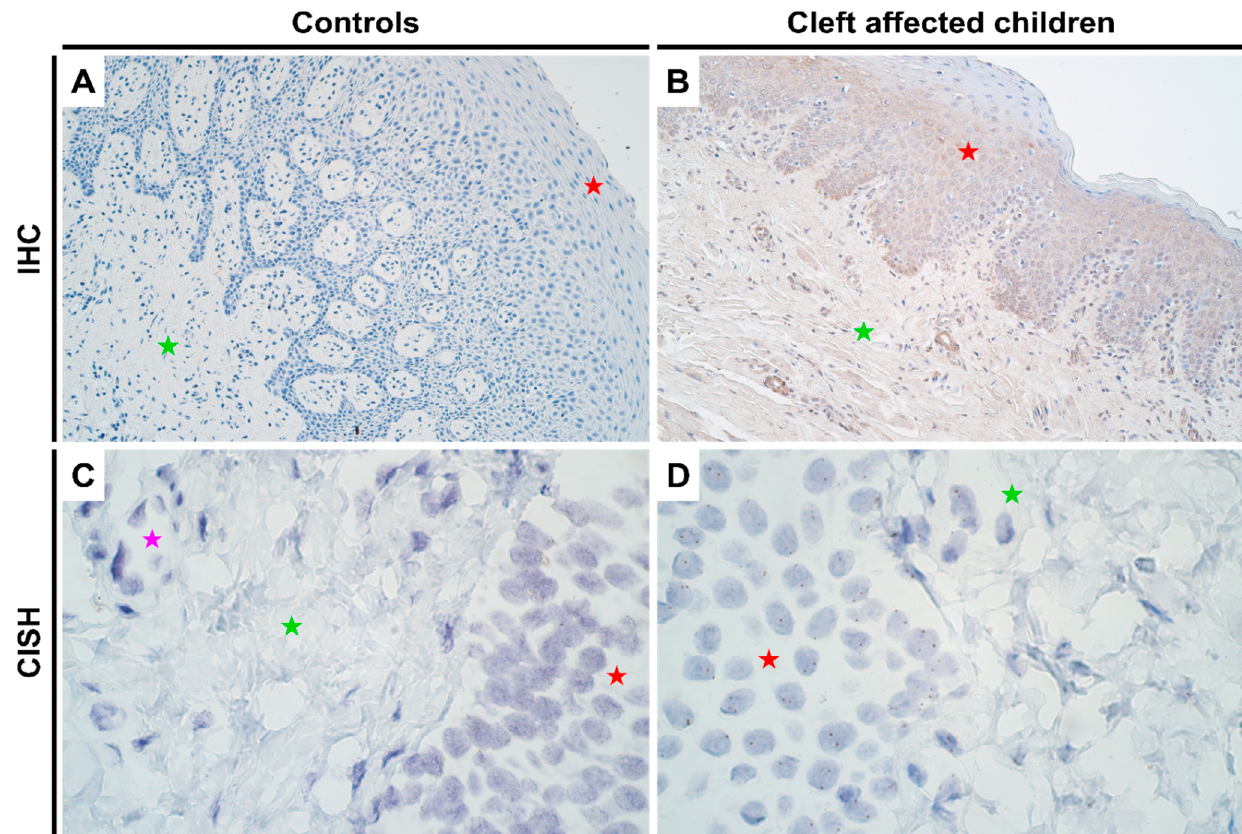
Figure 3. Expression of MSX2 gene visualized using IHC and CISH methods in controls and cleft patients. Protein expression of the MSX2 gene was visualized using immunohistochemistry (IHC) in ( A ) controls and ( B ) cleft affected children. ( A ) No positively stained (0) structures are visible in tissue obtained from controls; ( B ) Moderate number (++) of weakly stained epitheliocytes and endotheliocytes are seen in the cleft tissue obtained from a six-month-old girl. Original magnification, 200×. Gene amplification levels of MSX2 gene was visualized using chromogenic in-situ hybridization (CISH) in ( C ) controls and ( D ) cleft affected children. ( C ) No gene amplification (0) is seen in the tissue obtained from controls; ( D ) No gene amplification (0) is seen; however, gene expression is seen by brown dots in the nucleus of the epithelial, endothelial, and connective tissue cells in the cleft tissue obtained from a five-month-old boy. Original magnification, 1000×. Red star indicates epithelium; green star indicates connective tissue, while purple star indicates endothelial cells.